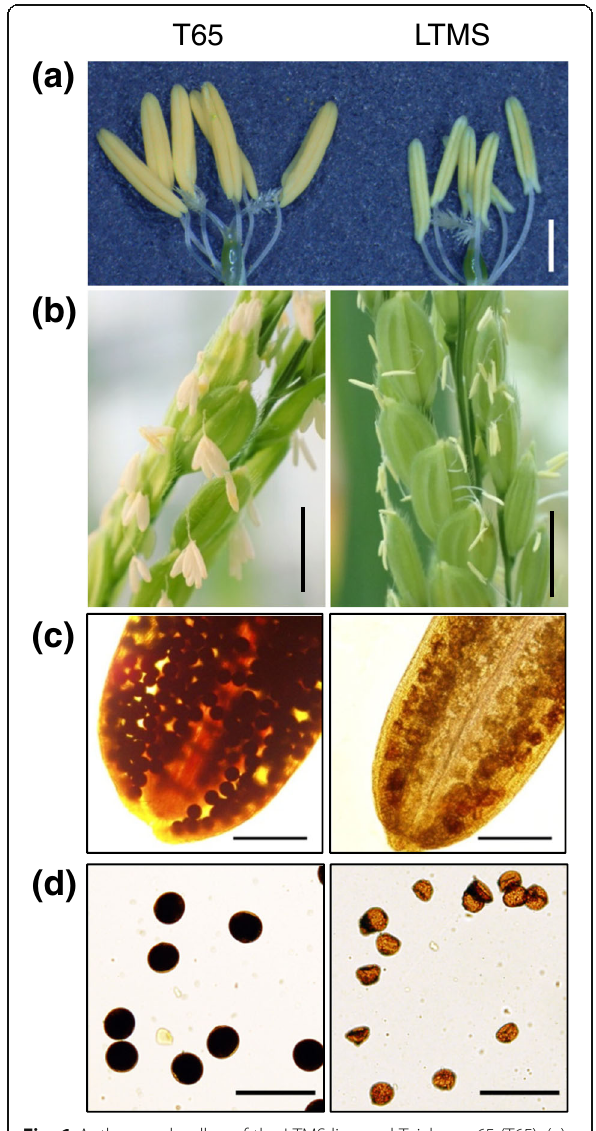
Fig. 1 Anthers and pollen of the LTMS line and Taichung 65 (T65). ( a ) Anthers before flowering (Bar=1 mm). ( b ) Anthers after flowering (Bar=5 mm). ( c ) Pollen in anthers stained with I 2 -KI (Bar=200 μ m). ( d ) Pollen grains stained with I 2 -KI (Bar=100 μ m) genome, except for a segment containing the LTMS gene. To reveal any genomic regions derived from Lebed, genotypes were determined for 65 INDEL markers covering all 12 chromosomes (Additional file 1: Table S3; Yonemaru et al. 2015). Genotyping of 10 plants revealed that a heterozygous Lebed /T65 genotype was detected only at INDEL759 in chromosome 10, as shown in Additional file 1: Table S4, while other parts were substituted with T65 chromosomal segments. This result indicates that the LTMS gene exists near INDEL759 in chromosome 10. Genotyping was further continued using newly designed INDEL and SSR